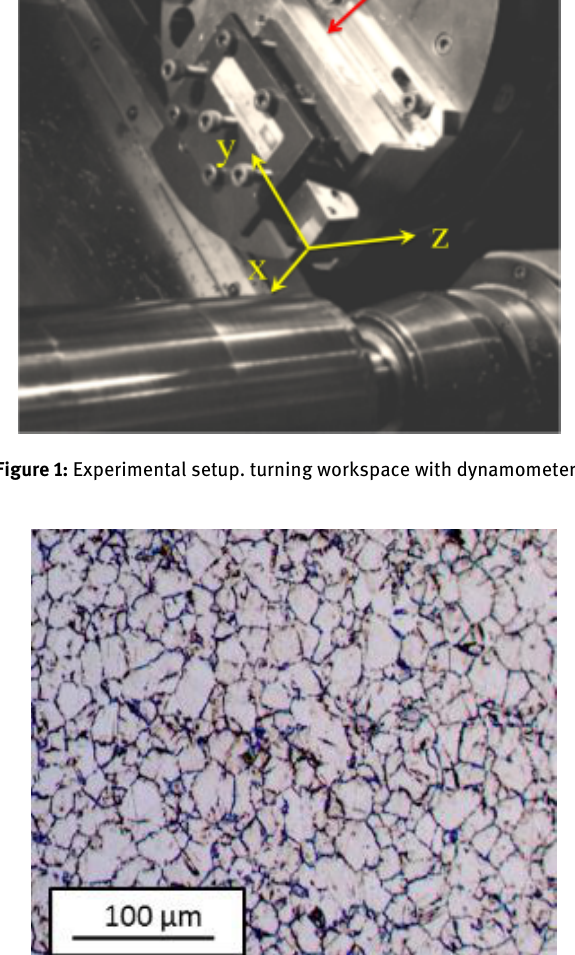
Figure 1. Also shows the Cartesian coordinate system: the mean tangential cutting force (parallel to cutting speed), Z direction (workpiece axis) and Y axis, the radial direction.